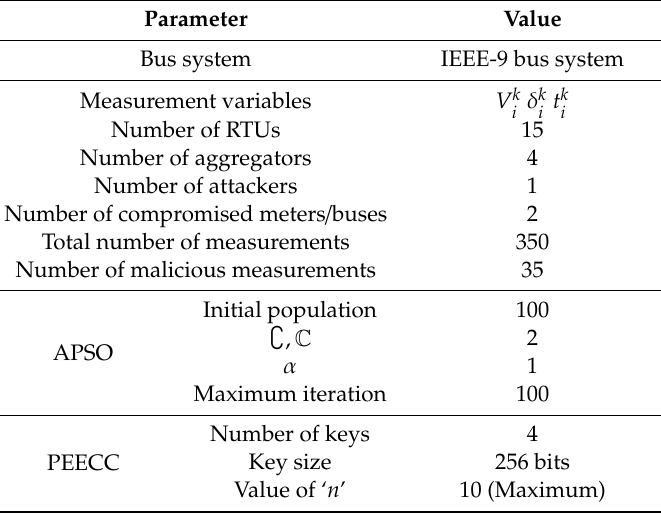
Table 3. Simulation parameters.